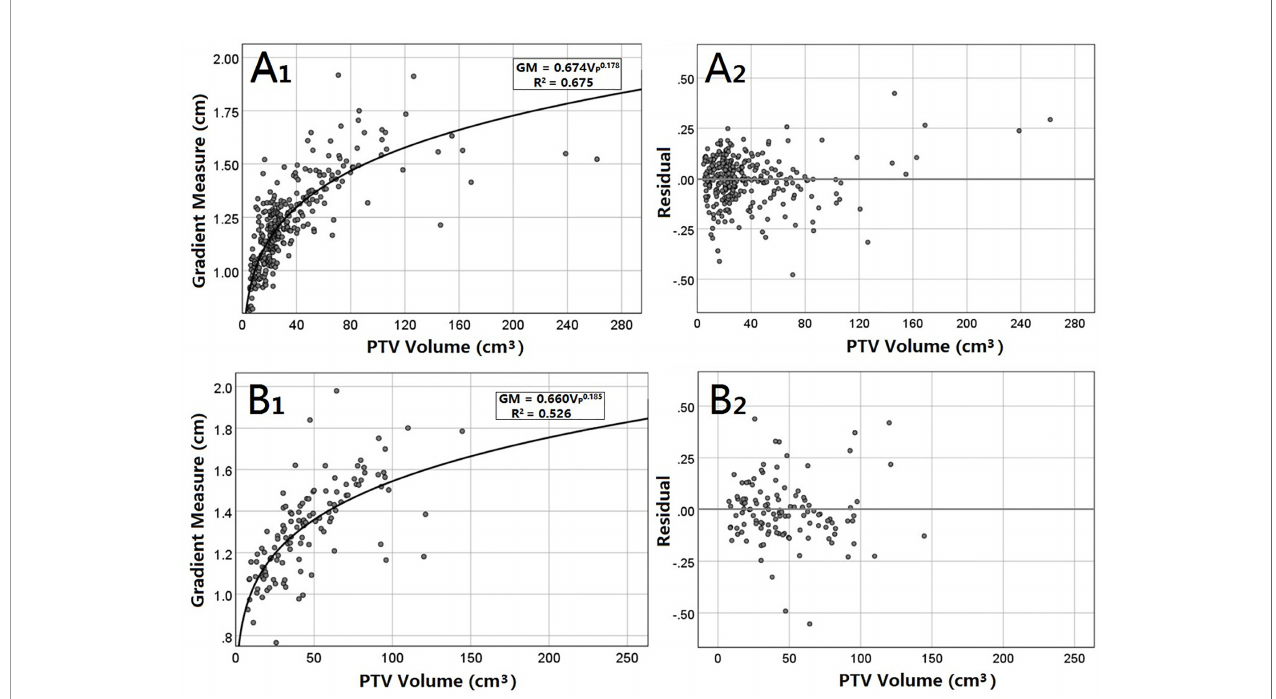
FIGURE 2 | GM versus the V P for peripheral (A) and central (B) lung SBRT plans. The least-squares fi t of the power equations (A 1 , B 1 ) is presented along with R 2 . In addition, residuals of the analytic GM minus the clinical GM are also presented (B 1 , B 2 )